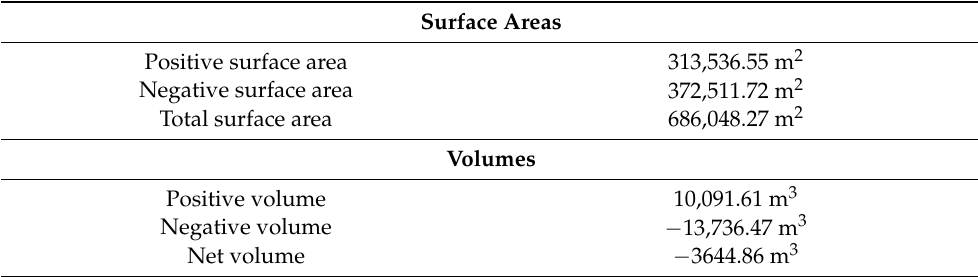
Table 2. Volumes and surface areas resulting from a comparison between the bathymetries